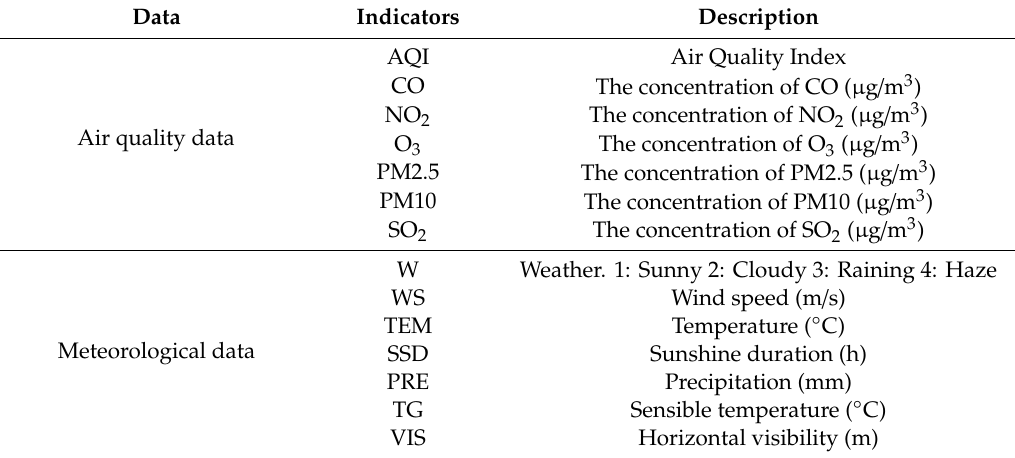
Table 3. Environmental data structure